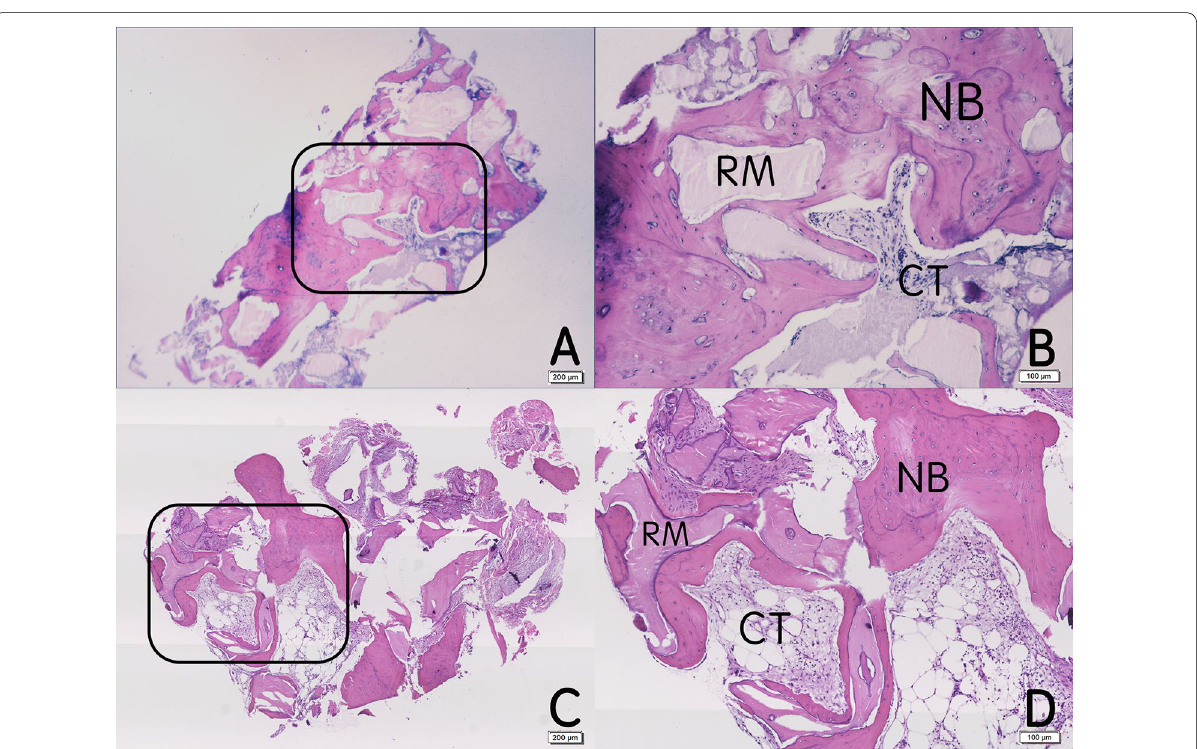
Fig. 4 Histological (HE staining) observation of the bone cores 8 months postoperatively for the CGFs/DBBM and DBBM groups. a CGFs/DBBM group ⅹ 40; b CGFs/DBBM group